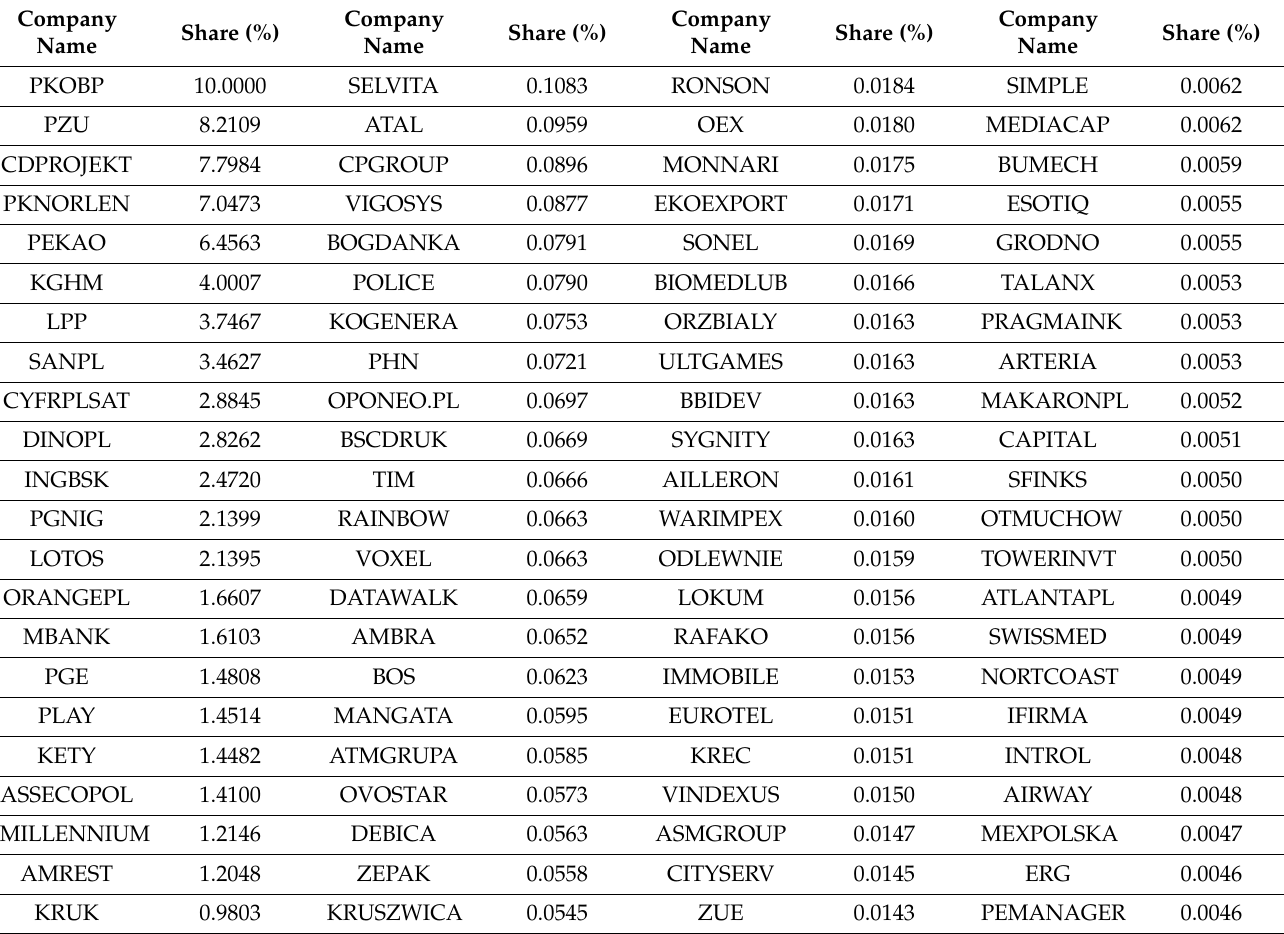
Table A1. Composition of the WIG index (after revision on 20 March